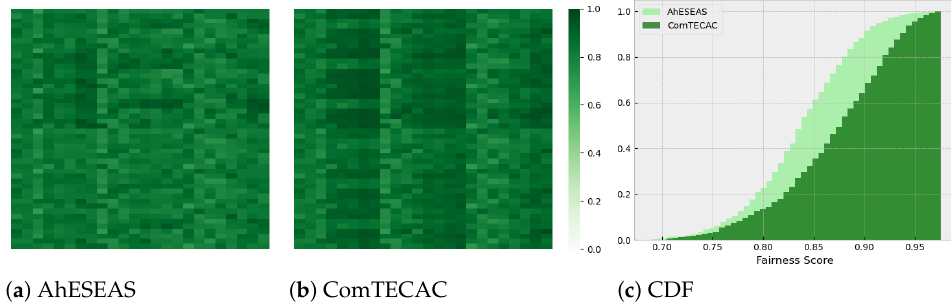
Figure 10. Recomputed fairness considering AhESEAS and ComTECAC heuristics only (dark is better).